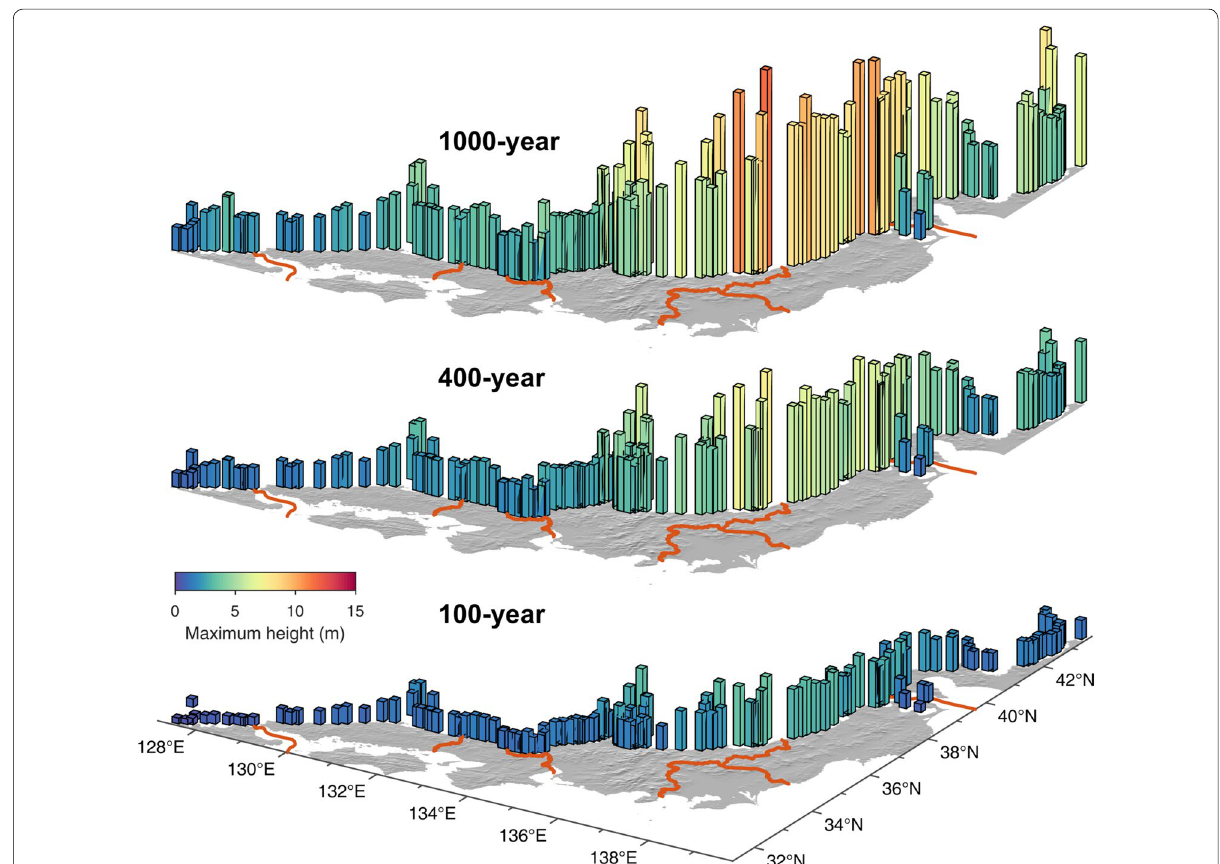
Fig. 8 Tsunami hazard maps for 100-, 400-, and 1000-year return periods. Red lines mark region